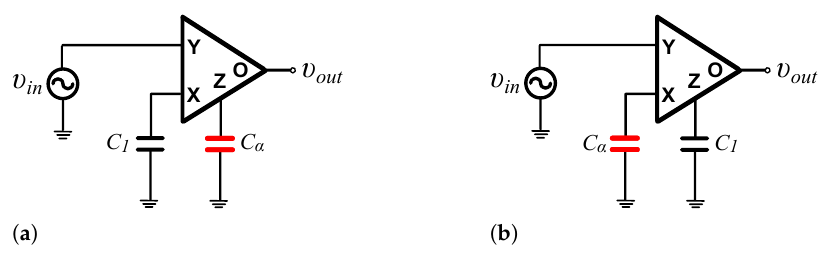
Figure 2. Proposed resistorless implementations of fractional-order ( a ) differentiator, and ( b ) integrator. Setting s α = ω α · [ cos ( απ /2 ) + j sin ( απ /2 )] , the expression in (1) expands as